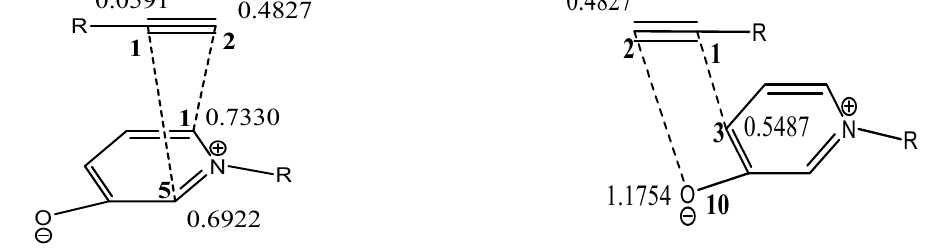
Scheme 4. Illustration of the favorable interactions using local electrophilicity indices. Table 2. Electrophilic and nucleophilic Fukui indices and local electrophilicities for the reactive atoms of 1 and 6 .